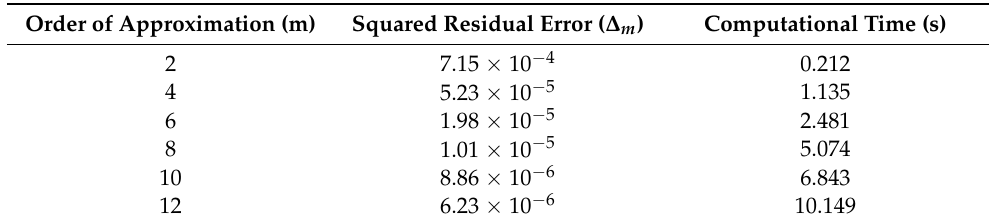
Table 2. Comparison between HAM-based approximation and numerical solution for the selected case. 𝒖